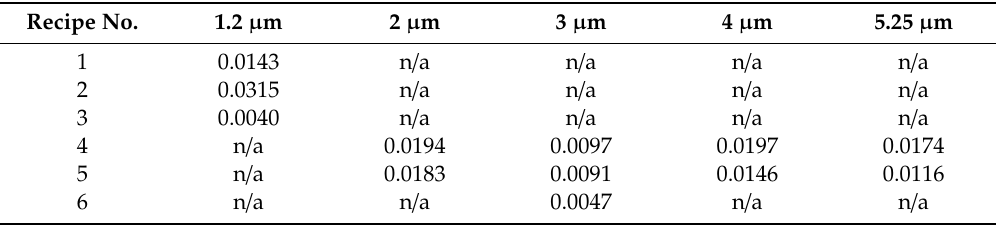
Table 2. S values fitted from experimental data with Equation (5).